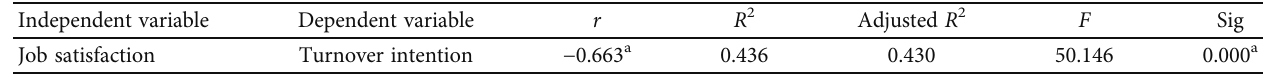
Table 6: Regression analysis of job satisfaction on turnover